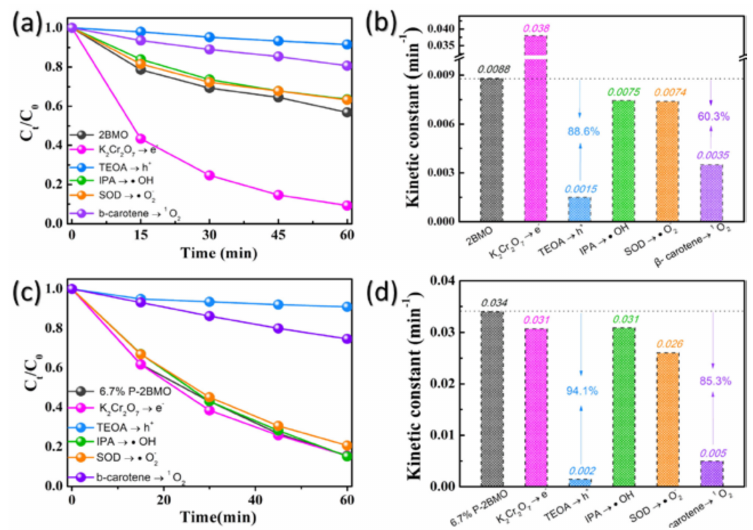
Figure 6. Trapping measurements and the corresponding rate constants for ciprofloxacin photodegradation over 2BMO ( a , b ) and 6.7% P-2BMO ( c , d ). Triethanolamine (TEOA); isopropanol (IPA); superoxide dismutase